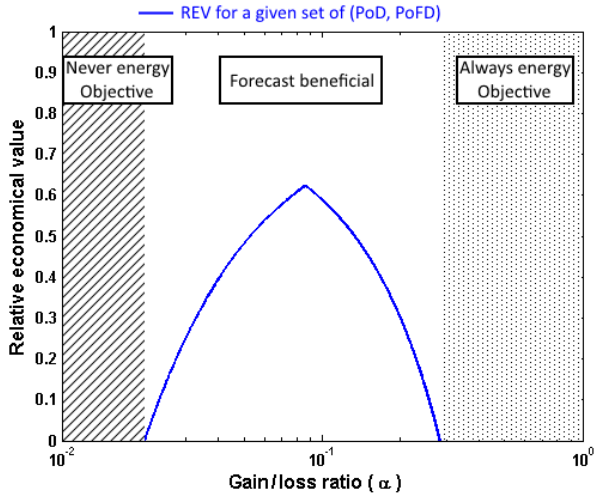
Figure 5. The 3 domains of operation of the REV curve as a func- tion of the gain–loss ratio α .